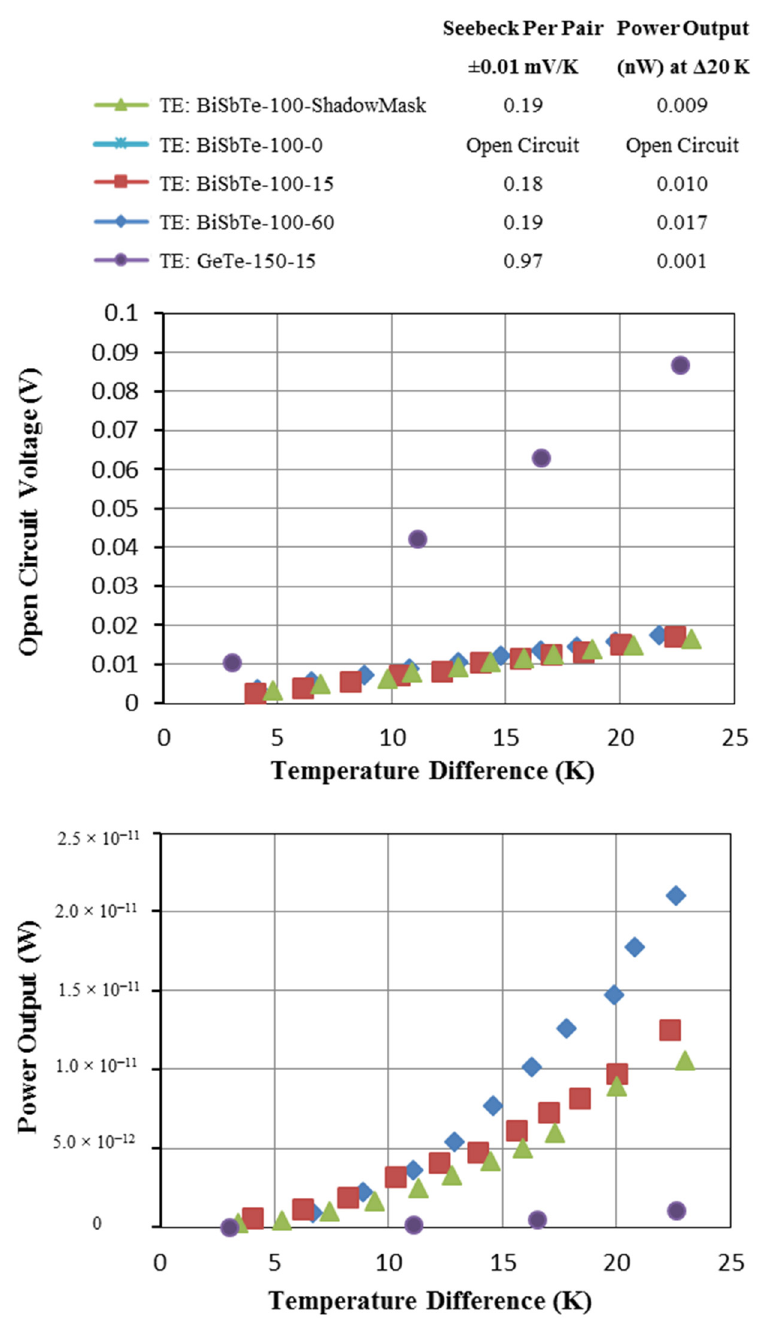
Figure 6. Seebeck open-circuit voltage and power output with temperature difference up to 24 K of BiTe/BiSbTe devices manufactured via pilot scale R2R coater and oil patterning, with electrodes cleansed of oil remnants by LEB. BiTe/BiSbTe control device with electrode patterned using shadow masking, BiTe/GeTe device manufactured using a combination of oil masked electrodes in R2R coater and thermoelectric layers in R&D scale static coating system. Devices were tested within 1 h of manufacture to compare TEG utilising shadow masked (no oil condition) and oil masked electrodes with postdeposition LEB oil cleansing. BiSbTe 100-0 data are not shown in graphs as they exhibit open circuit behaviour.